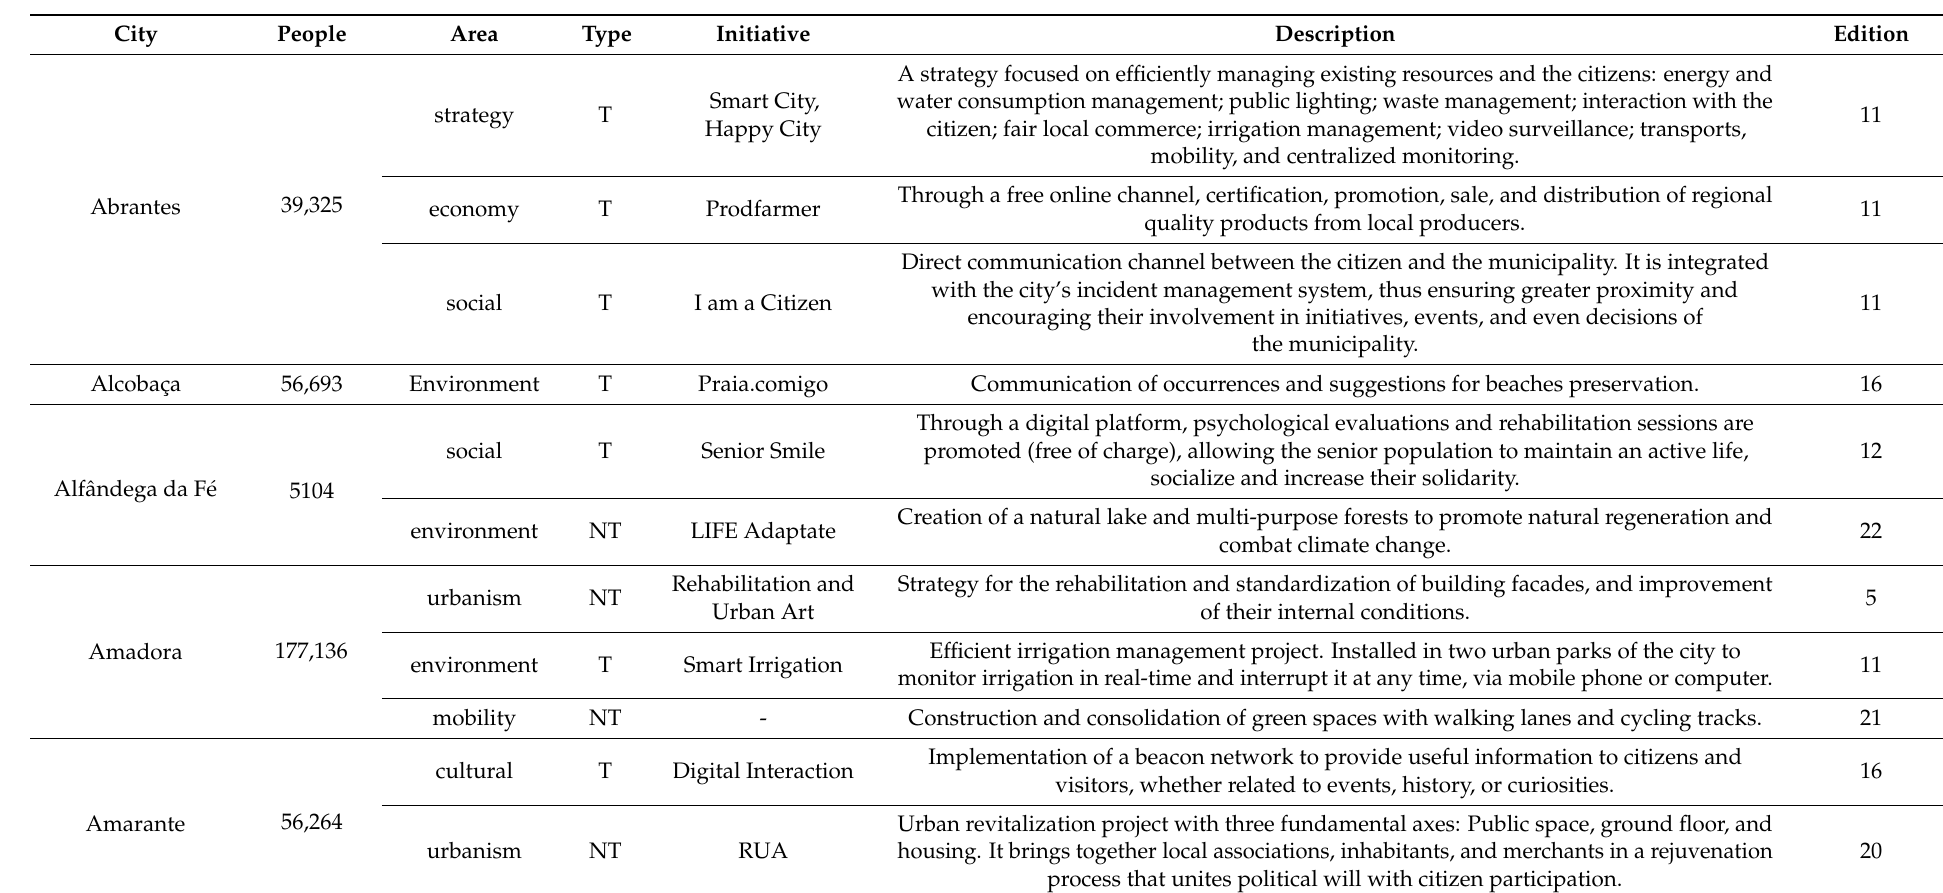
Table A2. Smart City Initiatives of Each Portuguese